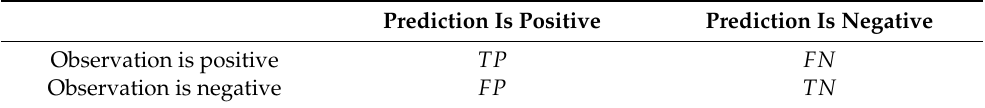
Table 1. Binary confusion matrix. Prediction Is Positive Prediction Is Negative Observation is positive TP FN Observation is negative FP